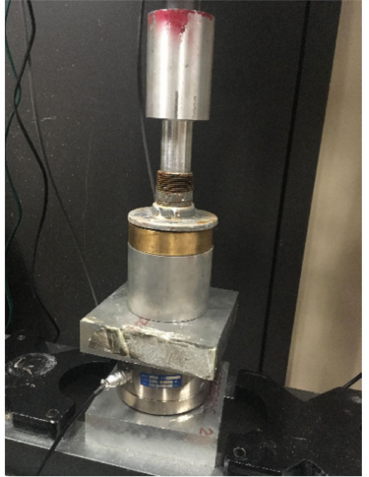
Figure 1. Cement shear bonding cell used for this work.